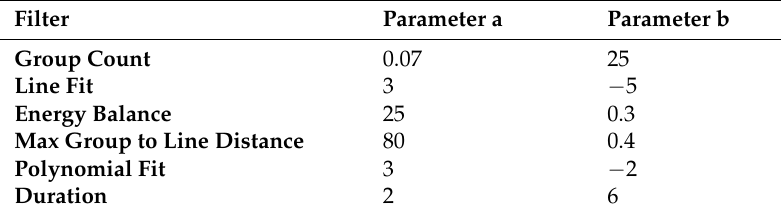
Table 2. Filter parameter set as they apply to the sigmoid function of the